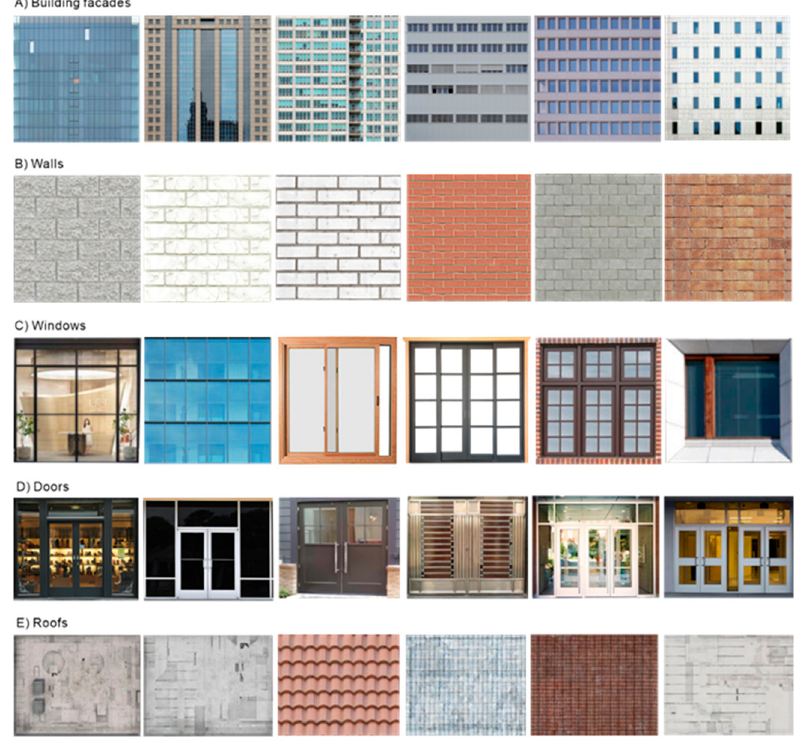
Figure 8. A land-used-based texture library. (( A ) Six types of building facades, namely commercial, official, residential, industrial, educational, infrastructure, and utilities; ( B – E ) showing 4 types of basic facade elements, namely windows, walls, doors, and roofs).